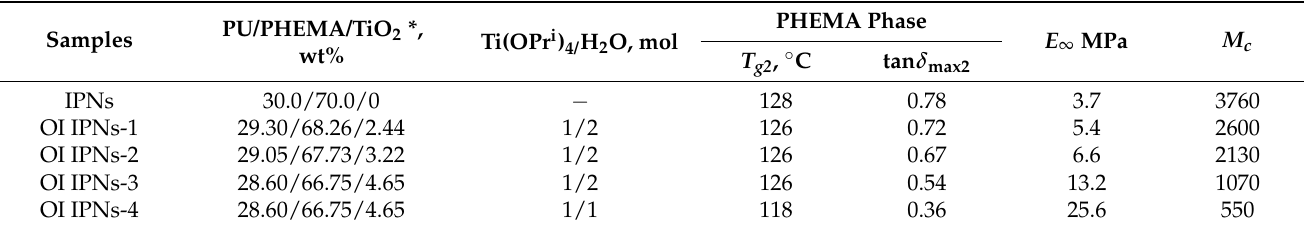
Table 1. Viscoelastic properties of IPNs and OI